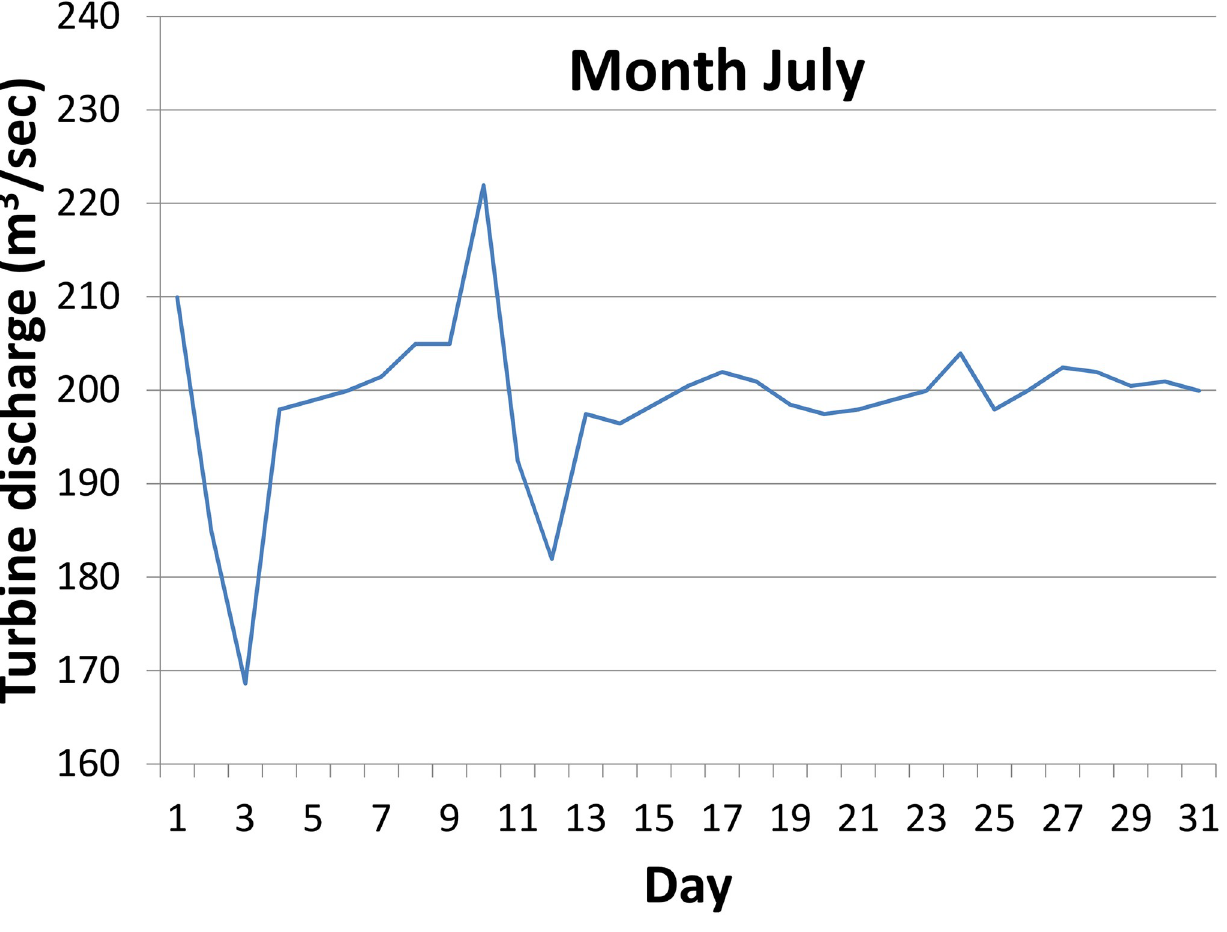
Fig 2. Volume of turbine discharge rate in the month of July, 2020.